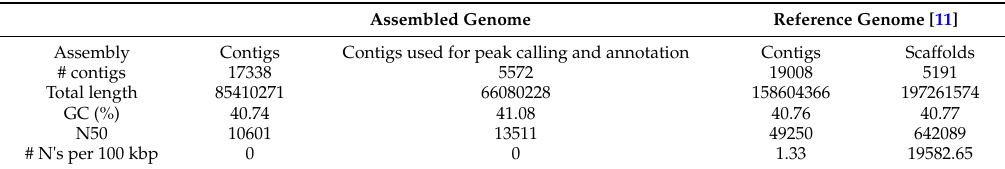
Table 3. Comparison of basic quality measures of assembled and reference genomes of Daphnia pulex . Assembled Genome